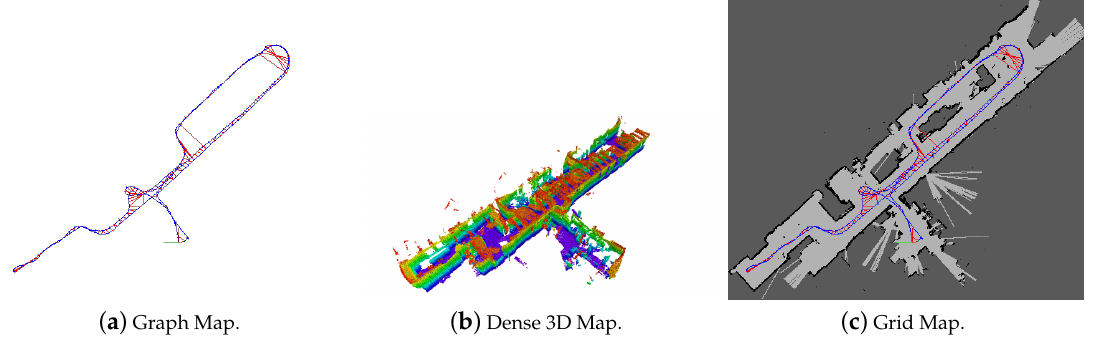
( a ) Graph Map. ( b ) Dense 3D Map. ( c ) Grid Map. Figure 3. Correspondence problem due to the different types of maps [31] of the same environment. ( a ) Graph map. ( b ) Dense 3D map. ( c ) Grid